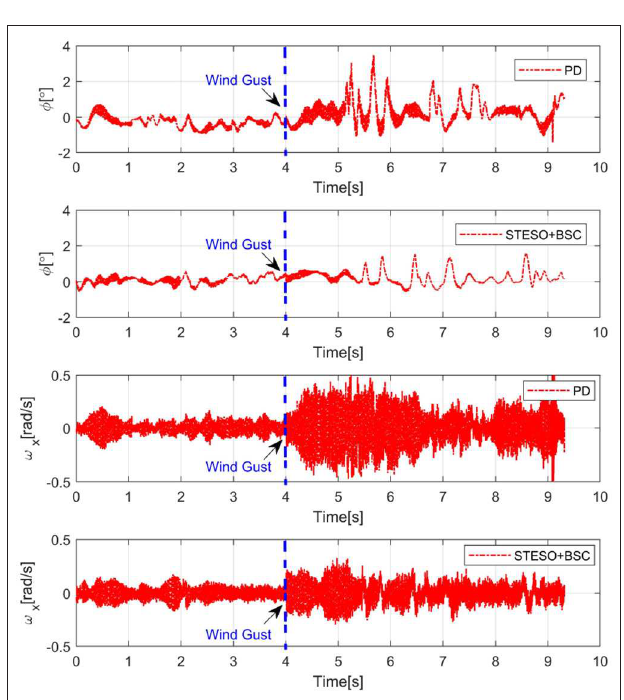
FIGURE 9 | Experimental curves of attitude angle ϕ and angular rate ω x during hovering with wind gusts.